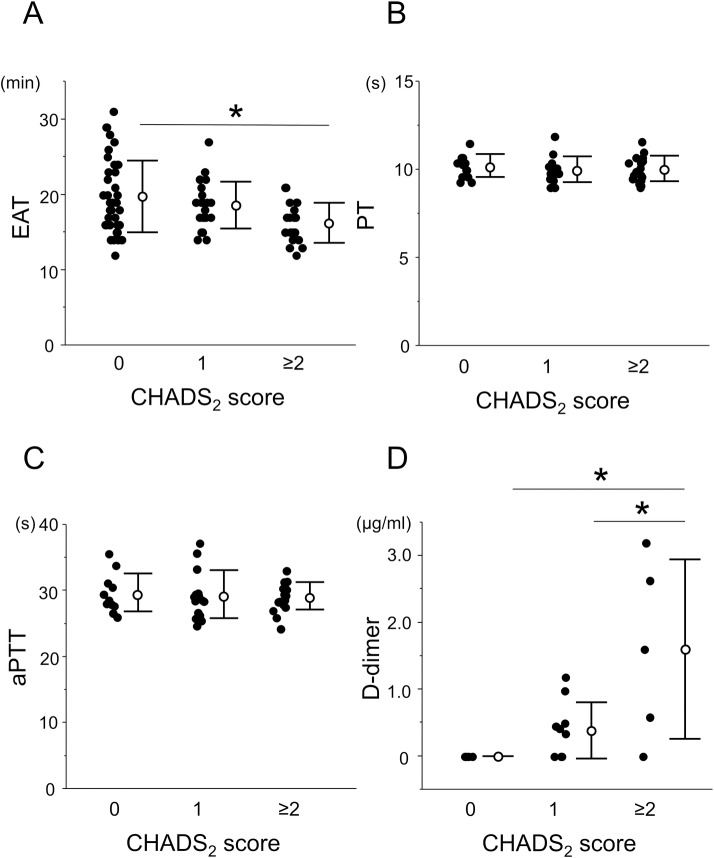
Coagulation parameters in the DBCM and conventional assays in groups with different CHADS2 scores.The patients were classified into 3 groups according to their CHADS2 score (0, 1, and ≥2) for a comparison with the EAT, (A), PT (B), aPTT (C) and D-dimer (D). The EAT and D-dimer showed a statistically significant difference in the 3 groups by ANOVA. Multiple comparisons revealed that the CHADS2 ≥2 group had a significantly shorter EAT than the CHADS2 = 0 groups and the CHADS2 ≥2 group had a significantly higher D-dimer level than the CHADS2 = 0 or 1 groups. The PT and aPTT exhibited no significant difference. *, p <0.05.